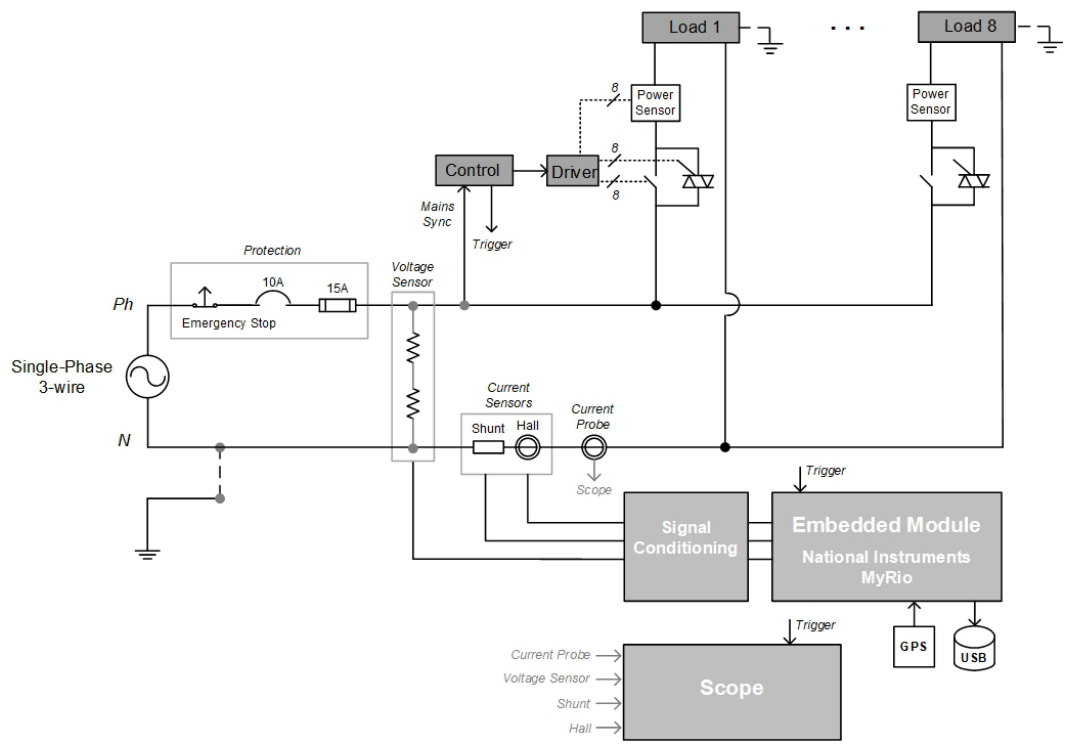
Figure 1. Block diagram of data collecting jig. adapted from